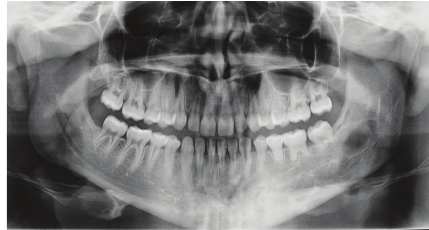
Figure 5: 8-year follow-up X-ray.